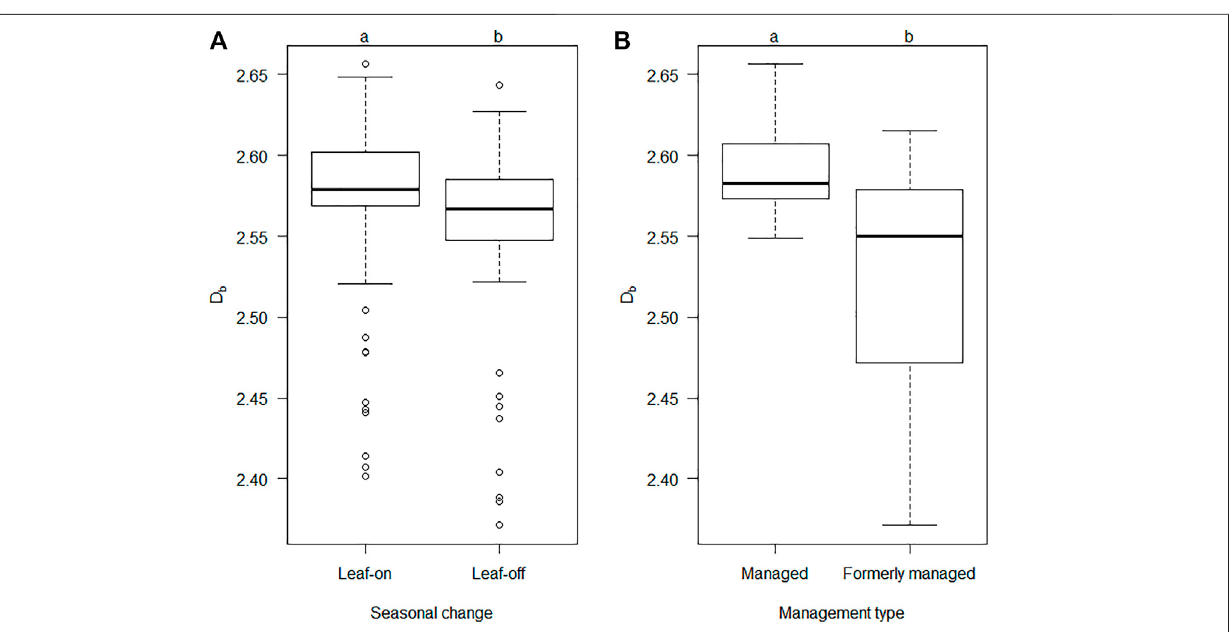
FIGURE 5 | Box-Whisker plot of the pooled box-dimension (D b ) of all plots for the seasonal change between leaf-on (summer) and leaf-off (winter) conditions (A) and the pooled box-dimension (D b )over differentmanagementtypes (B) .Black horizontal lines indicate themedian (n=64 for “ Leaf-on ” and n =55for “ Leaf-off ” ;n =63 for “ Managed ” , n = 56 for “ Formerly managed ” ). Different lowercase letters indicate signi fi cant differences among the conditions at the level of p < 0.05.